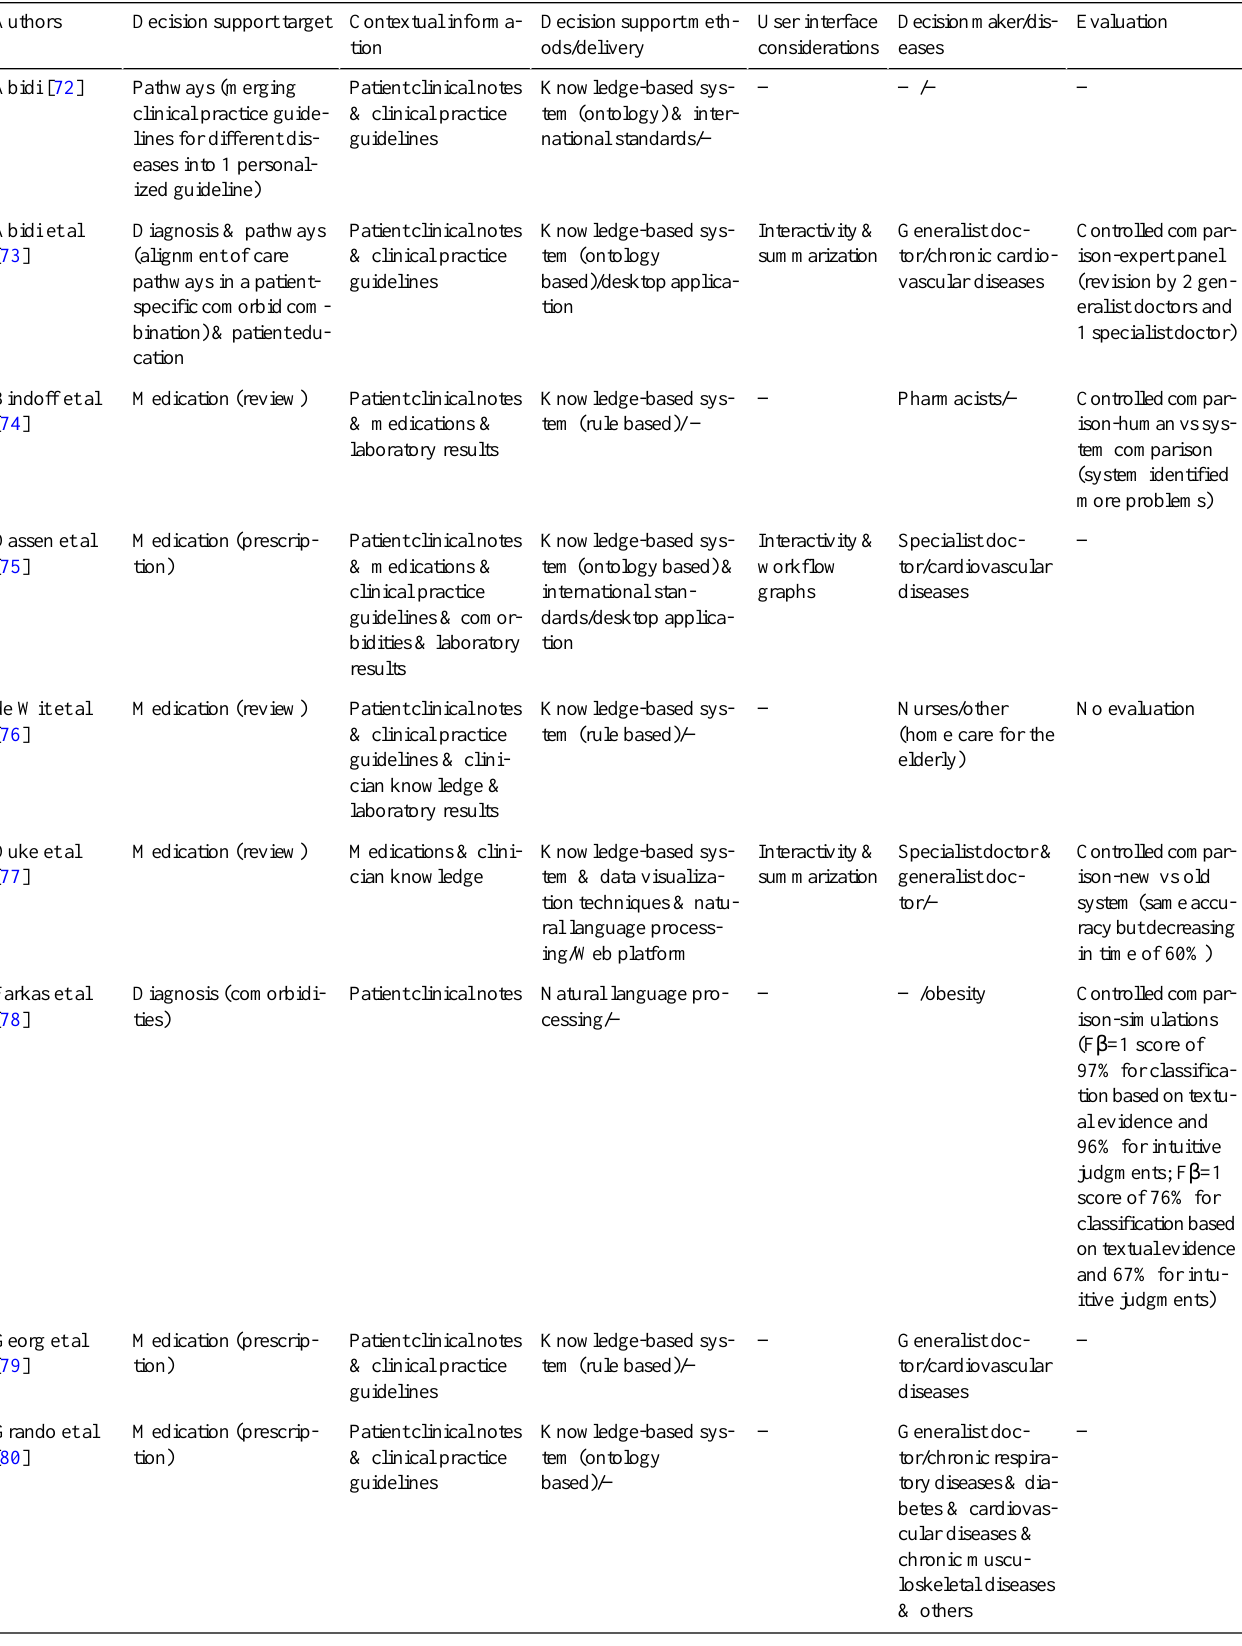
Table 1. Summary of collected items for included studies.